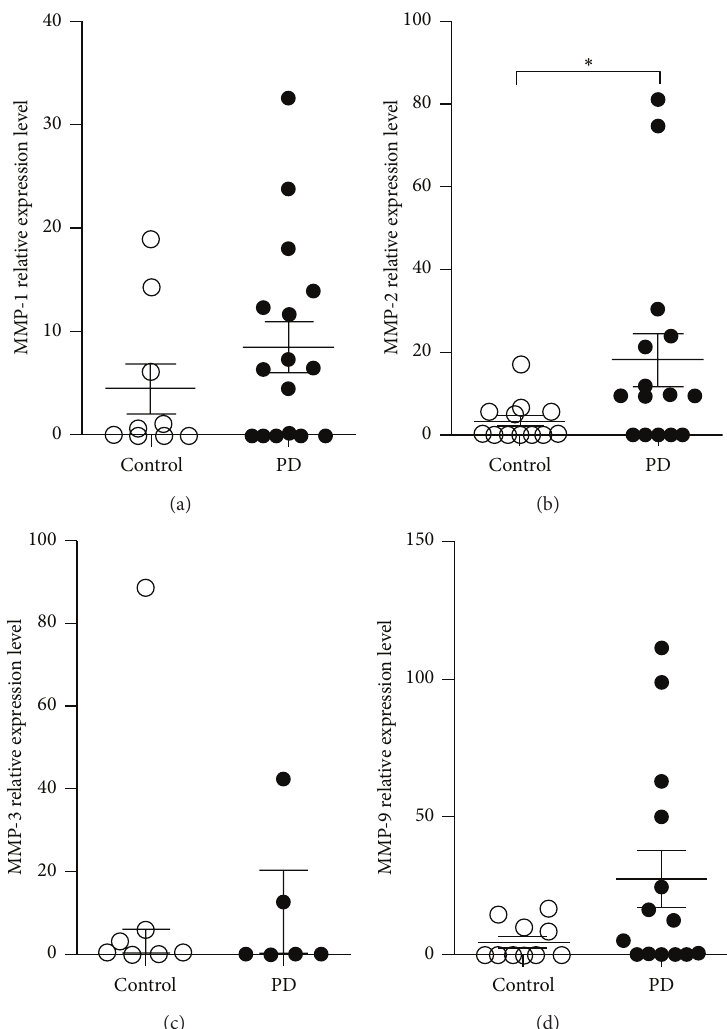
Figure 3: Metalloproteinases (MMPs) expression in alveolar bone tissue of control subjects and periodontal disease (PD) patients. Total RNA extracted from bone biopsies of PD and control groups was subjected to qRT-PCR, SYBR green method. RNA expression of MMP-1 (a), MMP-2 (b), MMP-3 (c), and MMP-9 (d) is presented as the intensity of expression of the individual mRNAs, with normalization to 𝛽 -actin, using the cycle threshold method. Data are the mean ± SEM results for patients with PD and control subjects tested individually. The results shown are from one experiment representative of three. ∗ 𝑝 < 0.05